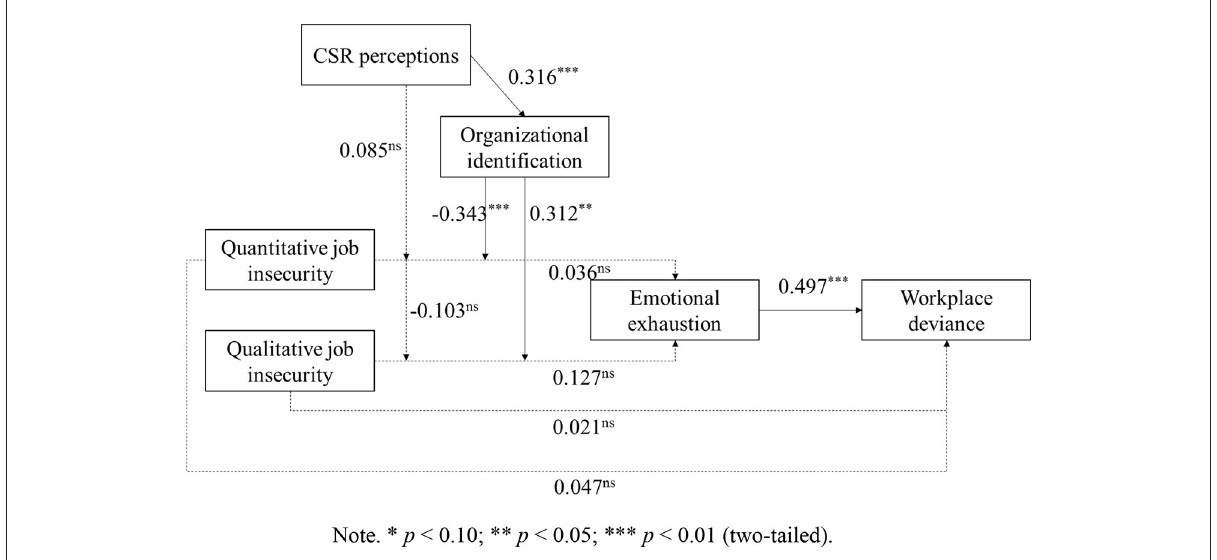
FIGURE2 Structural model. * p < 0.10; ** p < 0.05; *** p < 0.01 (two-tailed). ns, non significant.